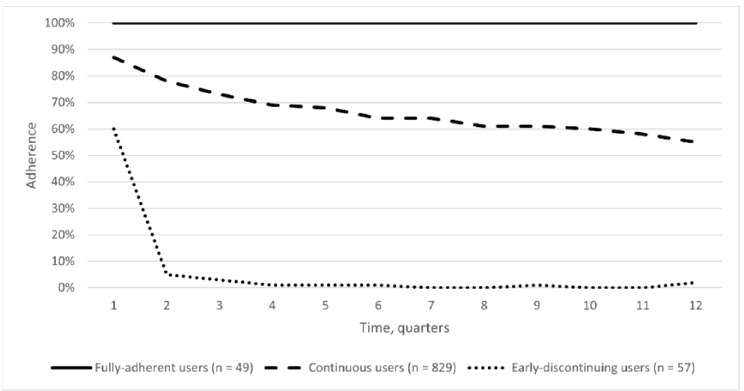
Table 1. Distribution of baseline characteristics of 952 new users of biologic DMARDs in 2010–2015 in Tuscany.